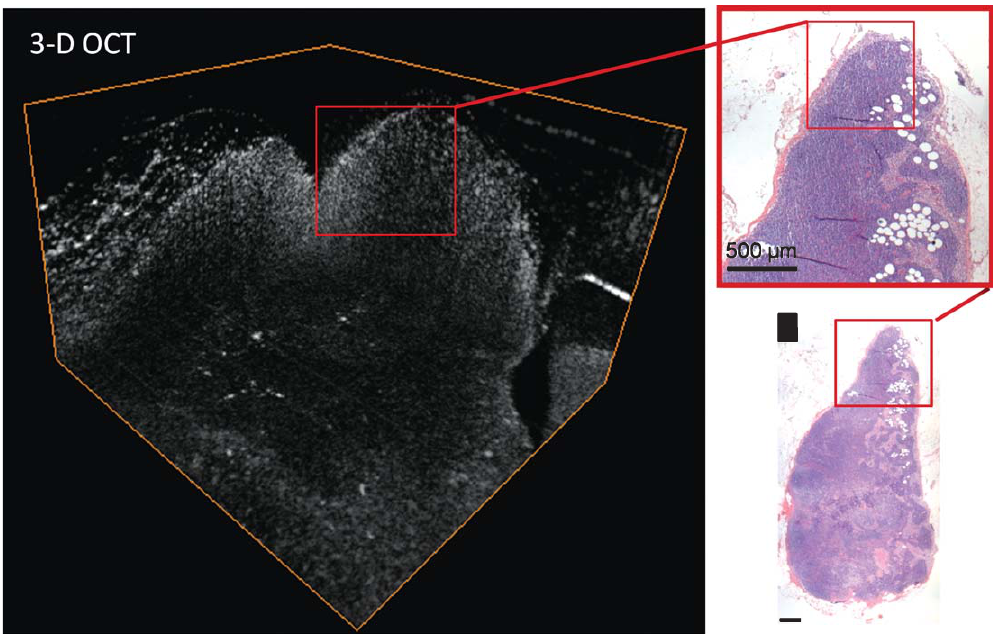
Fig. 9. 3-D OCT image and corresponding histology of a metastatic axillary lymph node. As with reactive lymph nodes, increased scattering from the node is observed in the OCT data, and the ability to differentiate distinct boundaries between the node capsule and cortex has been lost. The OCT image correlates to the regions in the histology that are highlighted by the red boxes. The volume of the 3-D OCT dataset is 5 × 5 × 1.7mm 3 . Figure used with permission from [61]. risk of morbid complications such as